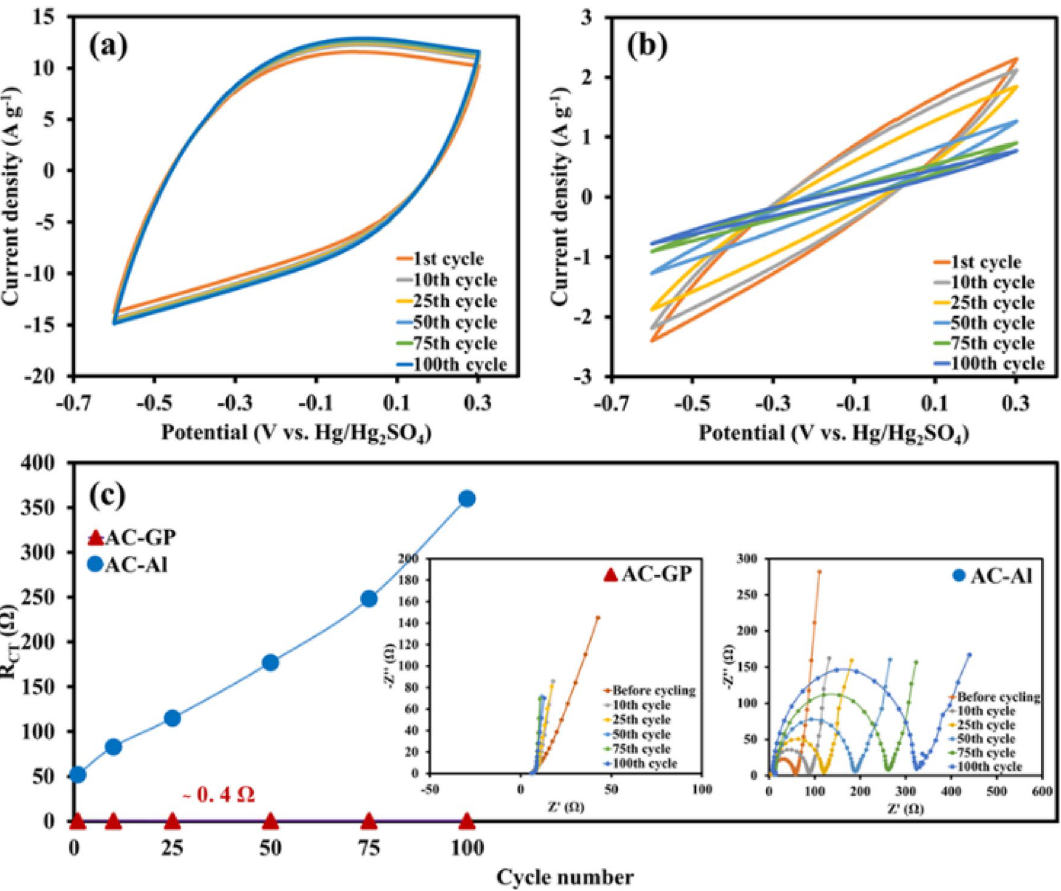
Figure 3. CVs at 100 mV s −1 of ( a ) AC-GP and ( b ) AC-Al and ( c ) Summarized R CT values as a function of cycle numbers (inset: Nyquist